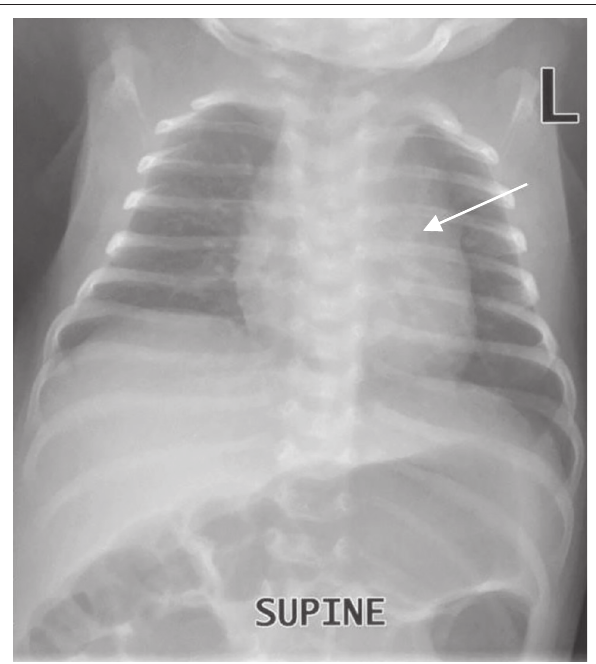
FIGURE 5: Frontal chest radiograph. There is a notch between the inferior border of the right lobe of the thymus and the heart (arrow).